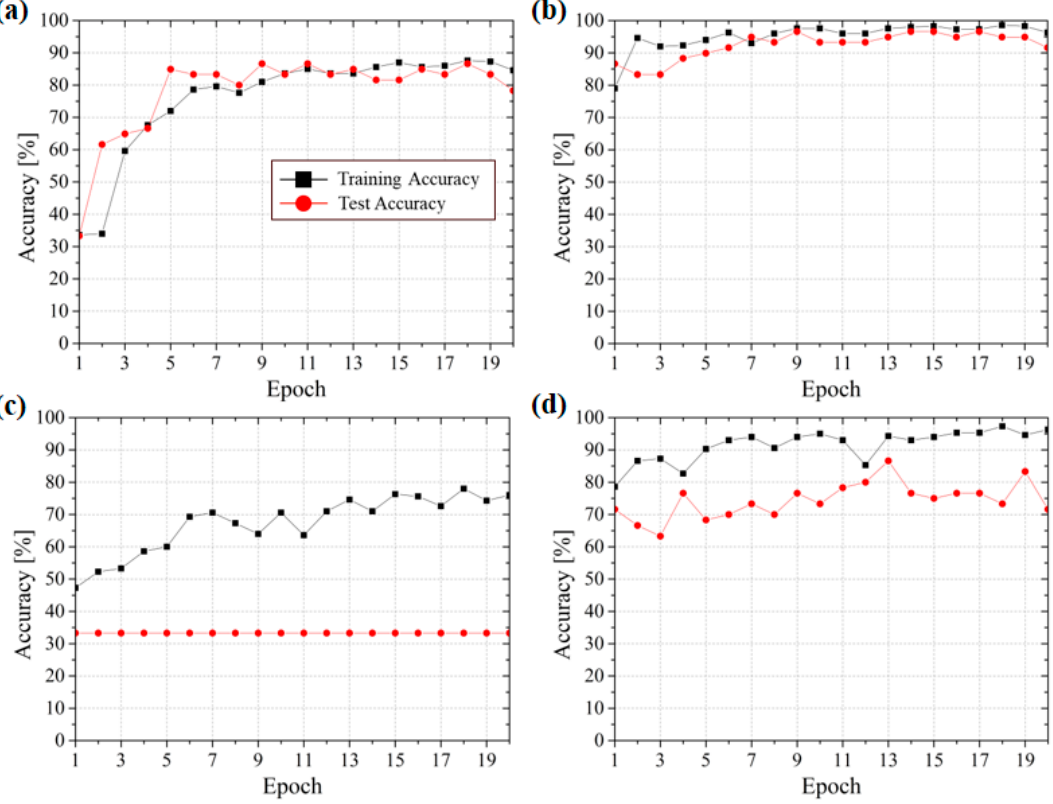
Figure 5. Accuracy of training and test for CNN and CNN-TL with 3-bands images. Black squares and red circles represent training accuracy and test accuracy, respectively: ( a ) VGG19 has high and stable accuracy for both training and test; ( b ) TL enhances its performance from the beginning of VGG19; ( c )